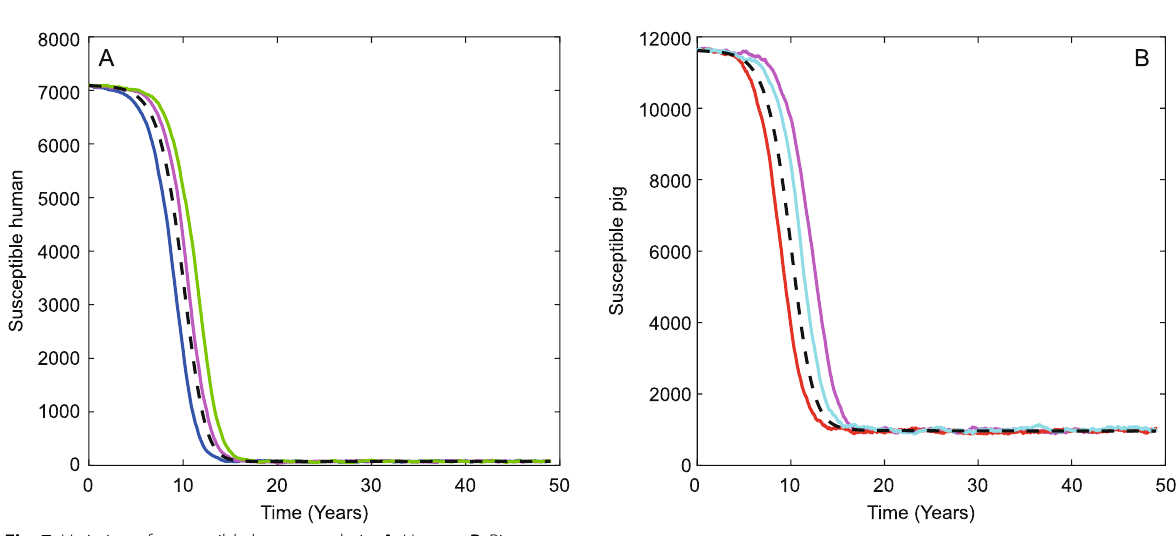
Fig. 7 Variation of susceptible human and pig. A . Human; B .